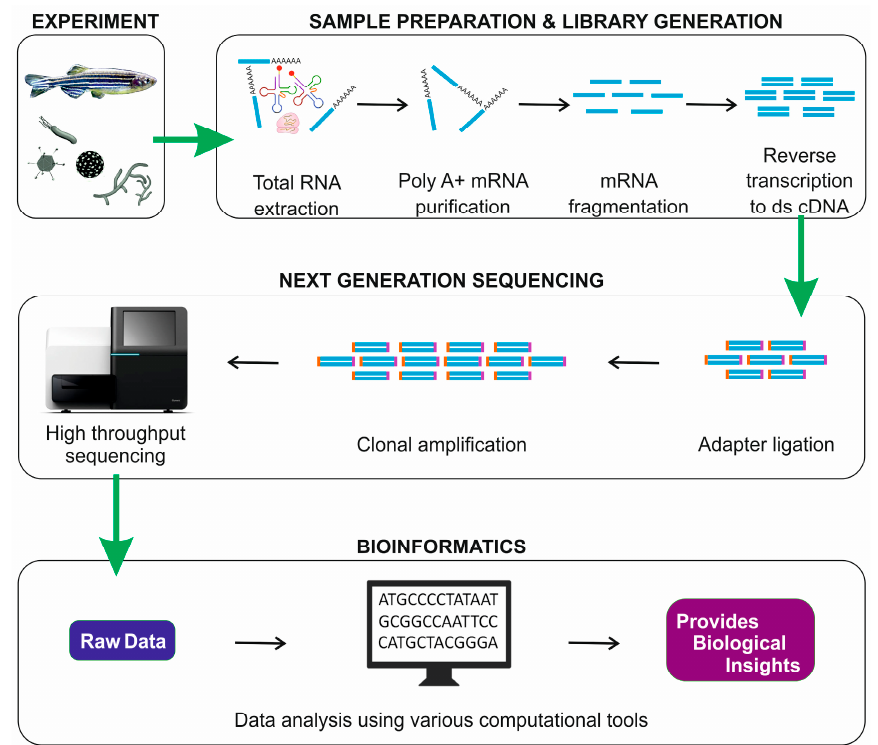
Figure 1. Illustration demonstrating the stepwise workflow of a conventional RNA-Seq-based transcriptome analysis. Four major steps are involved: (i) Experimental design; (ii) Sample preparation and library generation; (iii) Next-generation sequencing of the library; (iv) Bioinformatic analysis.